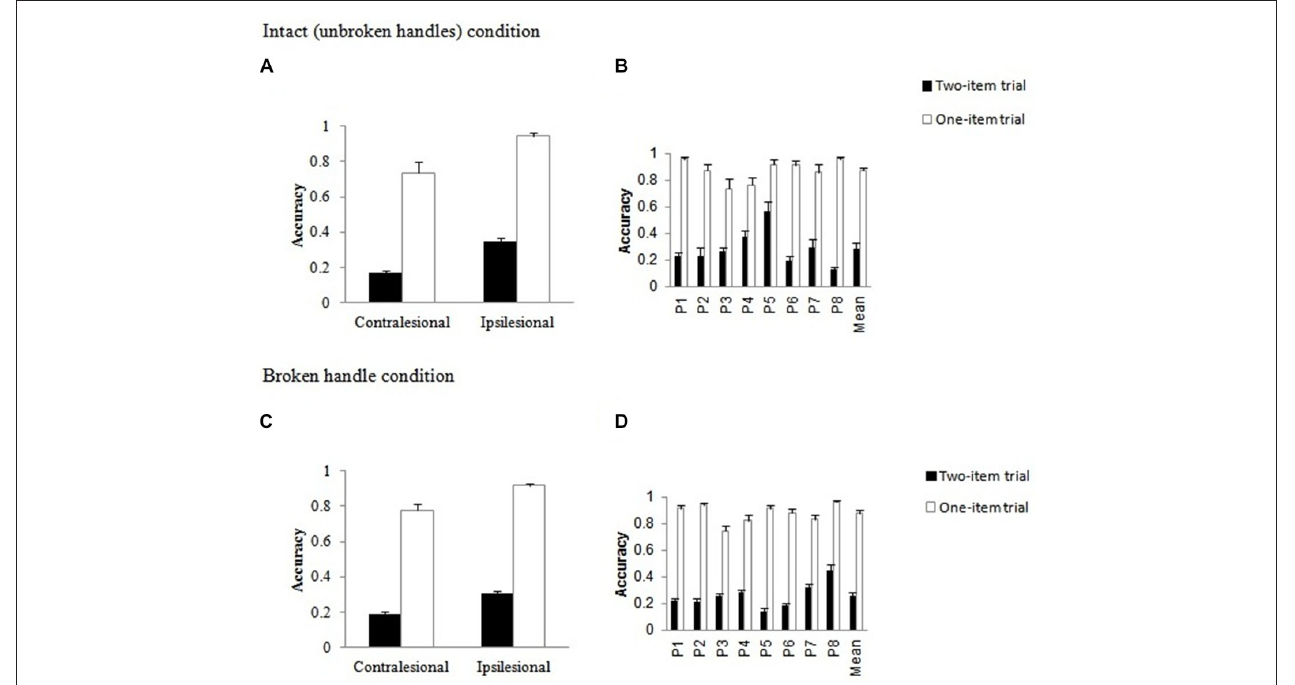
FIGURE 2 | Data for one-item and two-item trials in the Intact (unbroken handles) condition and in the broken handle condition as a function of side of stimulus. Mean accuracy of performance (A,C) and mean patient accuracies (B,D) with error bars indicating standard error (SE).